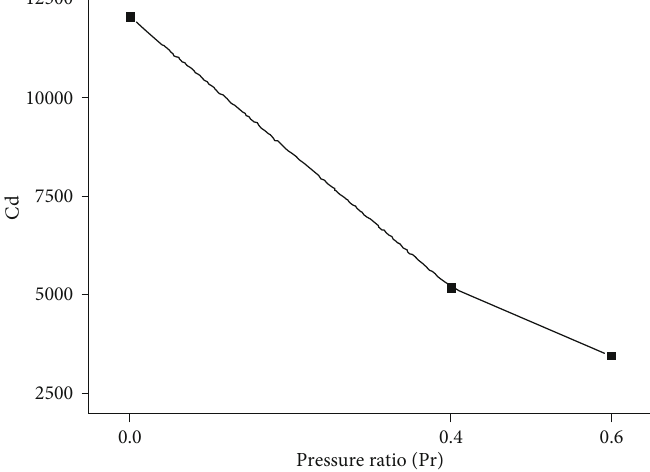
Figure 8: Resistance coe ffi cient changes with pressure ratio at di ff erent pressure ratios without the angle of